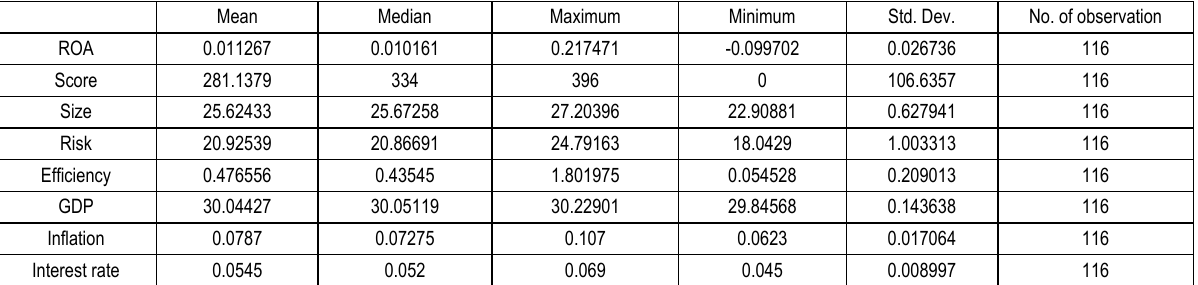
Table 2. Descriptive statistics of the